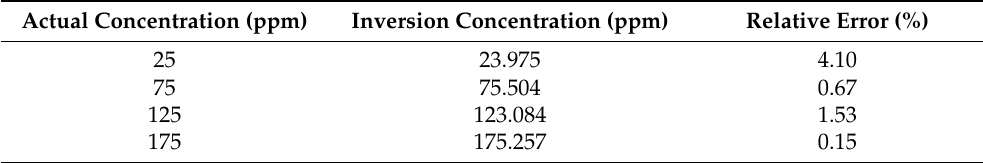
Figure 8. The relationship between the ring-down time and the gas concentration.